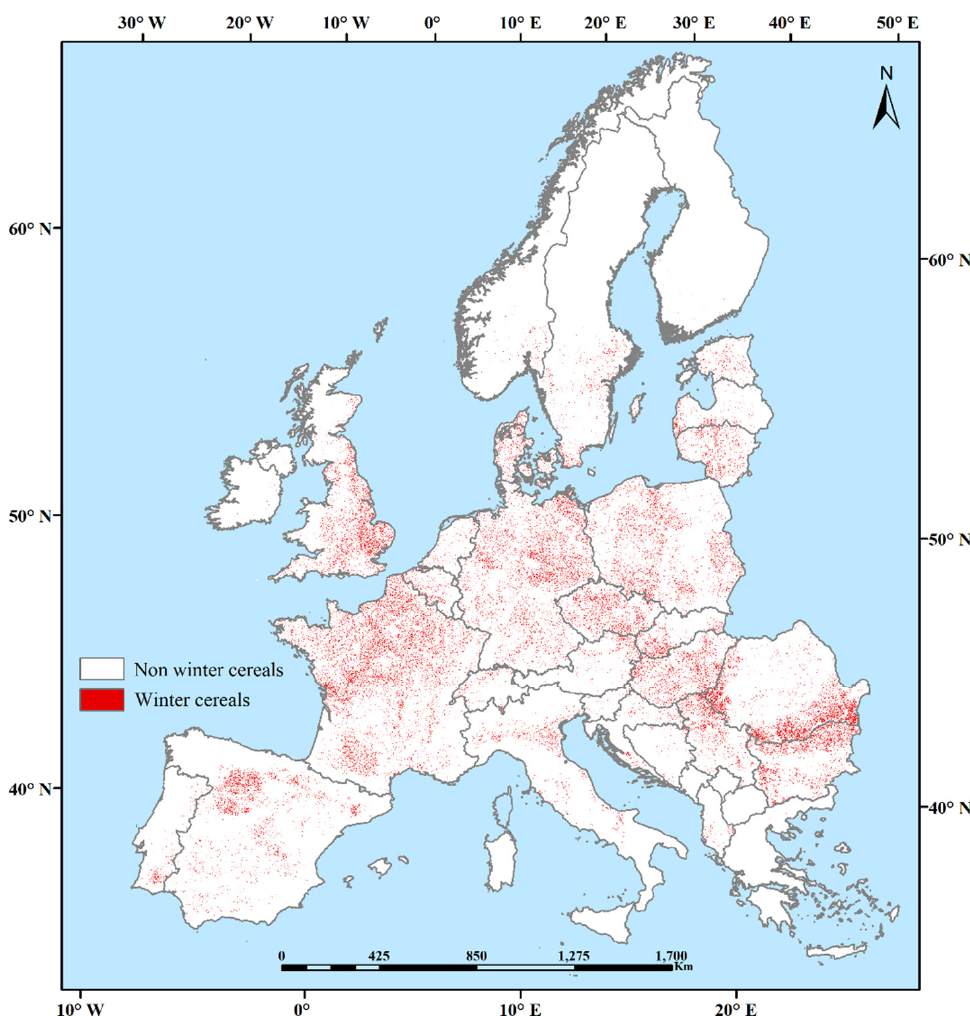
Figure 5. The distribution of winter cereals for 32 European countries in 2018. The red pixels show the geographical locations of identified winter cereals, and white show non-winter cereal areas.